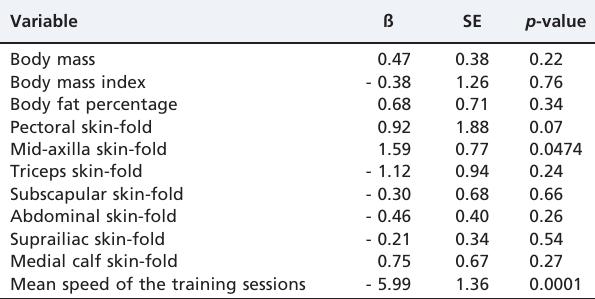
Table 4 - Relationship of race time in the half-marathon to selected variables of anthropometry, training and pre race experience in the multiple linear regression analysis.